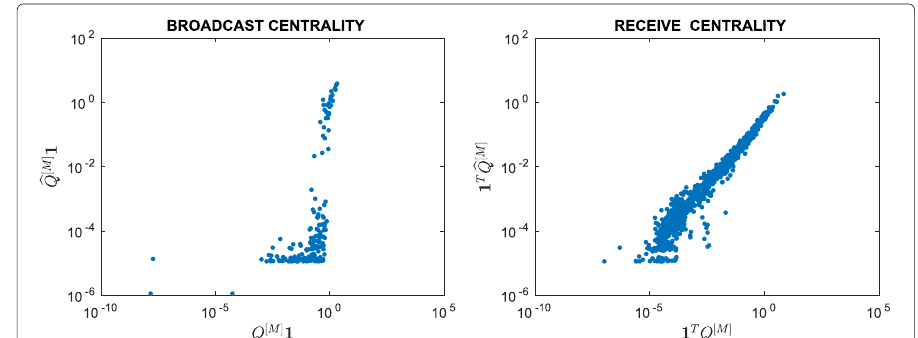
Fig. 10 Scatter plot. FBsoc: approximation using (4) with α = 0.1